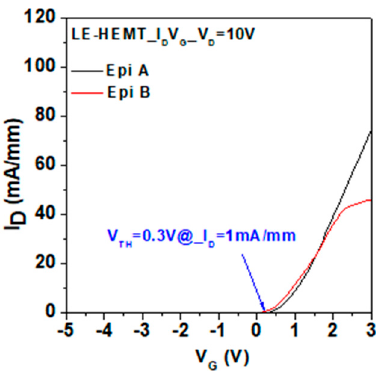
Figure 4. Typical I D -V G characteristics of LE-HEMTs with both structures in this study.